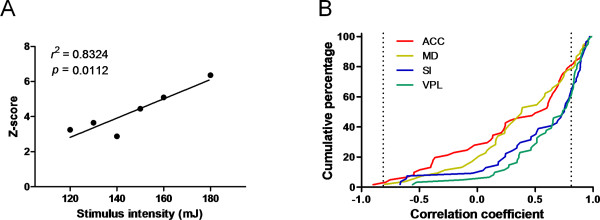
Wide-dynamic coding of stimulus intensity. (A) An example of a WDR neuron that showed positive correlation between normalized firing rate (Z-score) and stimulus intensity. (B) The cumulative distribution of correlation coefficients (Z-score vs. laser intensity). The dotted lines indicate the upper and lower limits, respectively, of the normal range. Correlation coefficients that lie outside these limits were considered significant. Thus, the cumulative percentage outside the limits represents the proportion of WDR neurons for each region.